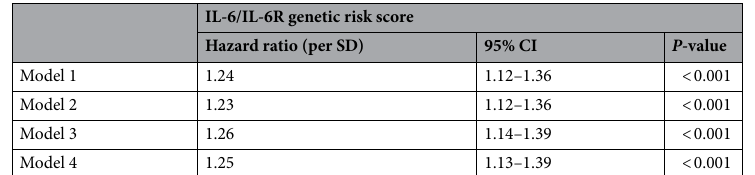
Table 4. Associations of interleukin-6/interleukin-6 receptor genetic risk score with rejection following kidney transplantation. Data are presented as hazard ratio with 95% confidence interval (CI) and P -value. Model 1 crude model. Model 2 adjusted for model 1 plus donor characteristic’s: donor age, donor sex, donor blood type, and donor origin. Model 3 adjusted for model 1 plus recipient characteristic’s: recipient age, recipient sex, recipient blood type and dialysis vintage. Model 4 adjusted for model 1 plus transplant characteristic’s: cold and warm ischemia time, the total HLA-mismatches, and the occurrence of delayed graft function (DGF).